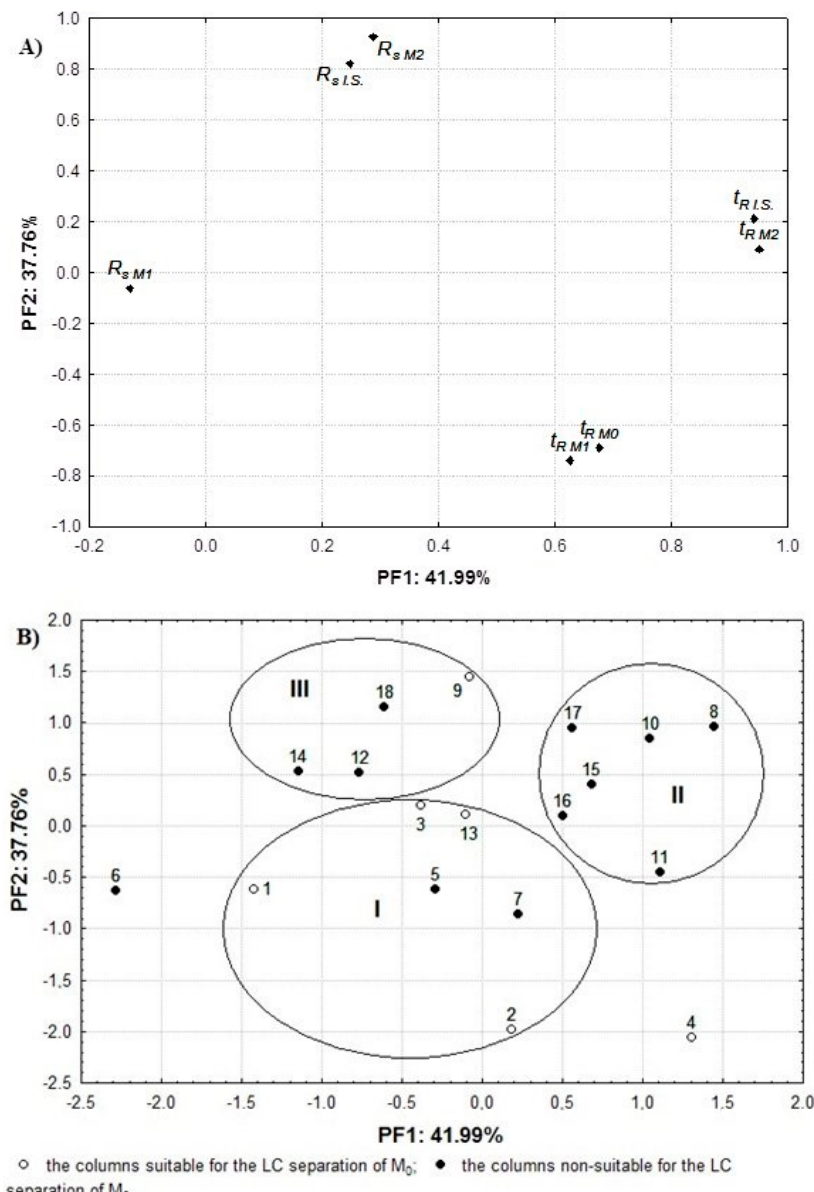
Figure 2. The FA plot for the variables ( A ) and objects ( B ) established for the auto-scaled retention parameters ( t R and R s ) of the compounds of interest during the column performance test based on the LC analysis of M 0 and its two metabolites.